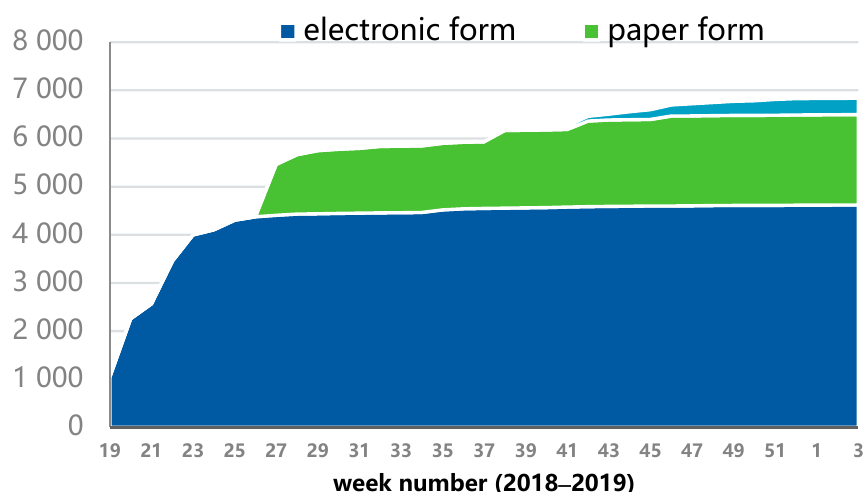
Figure 2. Data collection methods and number of respondents per week.